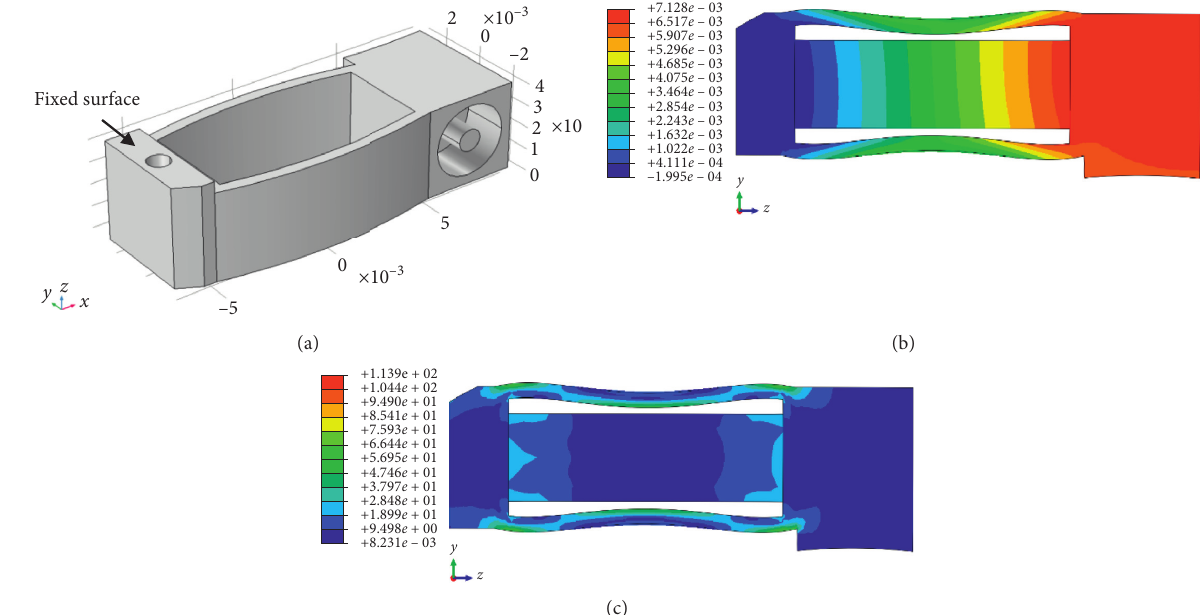
Figure 3: The design and analyze of rhombic mechanism. (a) Model sketch. (b) Deformation under driving voltage of 120 V. (c) Stress under driving voltage of 120V.